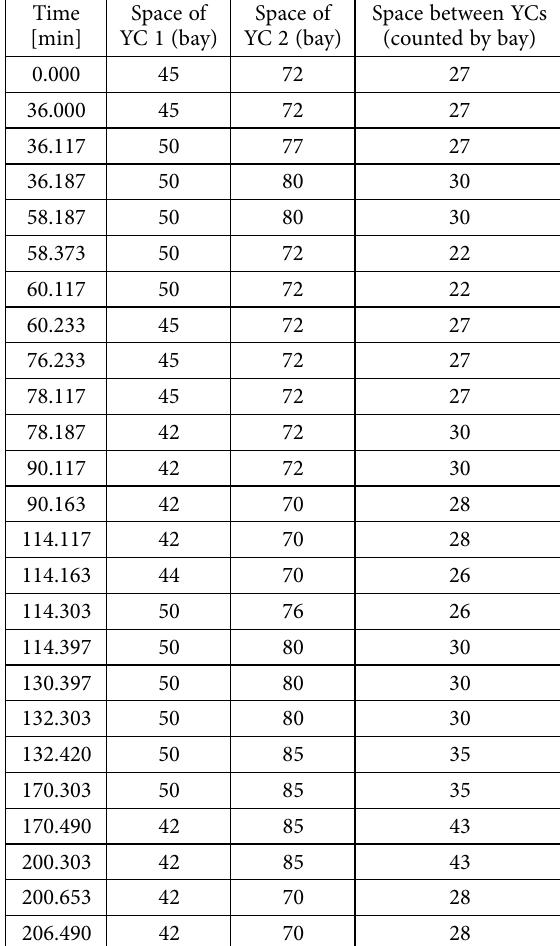
Table 6. The time-space details of two YCs